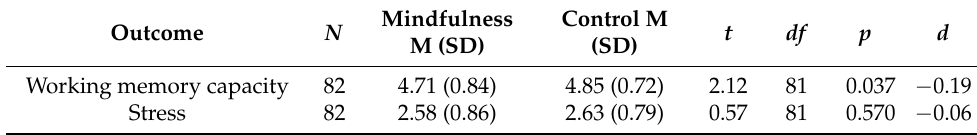
Table 2. Summary of Outcomes in Study